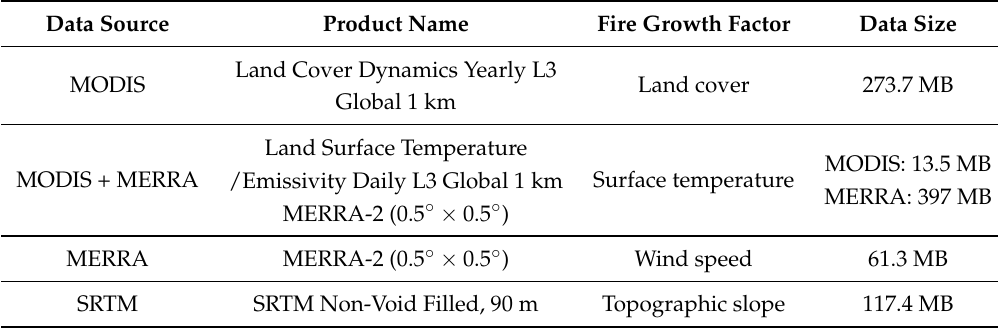
Table 6. Array schemas of each data type in